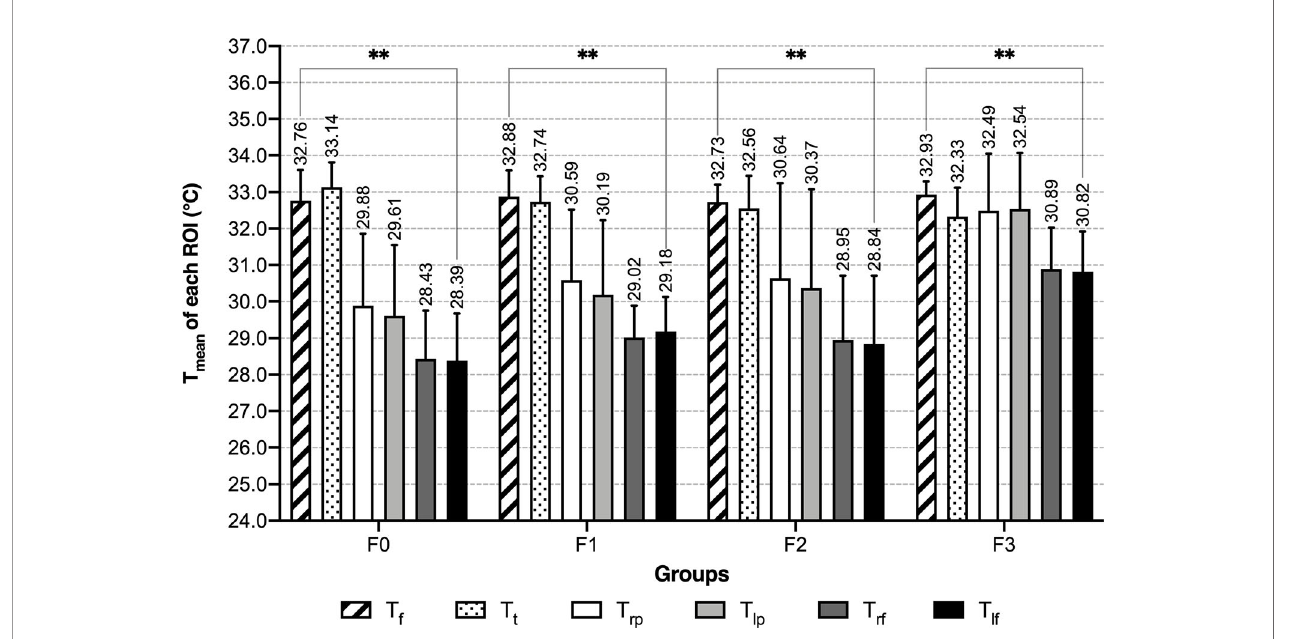
FIGURE 6 | T mean of each ROI of female groups - grouped by number of abnormal indexes. **: P < 0.01.